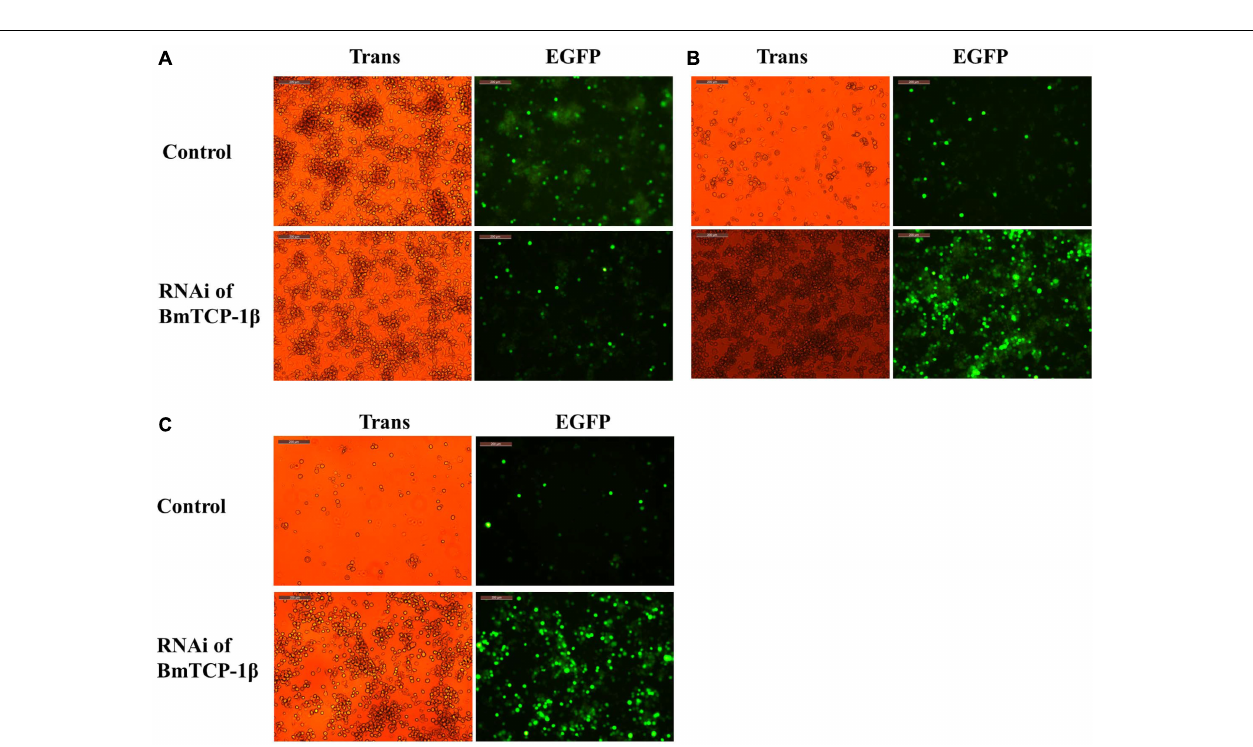
FIGURE 4 | Infection analysis of BmNPV in BmN cells following addition of BmTCP-1 β RNAi for different time periods. (A) 48 h after BV-EGFP infection. (B) 72 h after BV-EGFP infection. (C) 96 h after BV-EGFP infection. Scale bar, 200 µ m. Trans (white), optical transmission; EGFP (Green), expressed following the replication of BV.